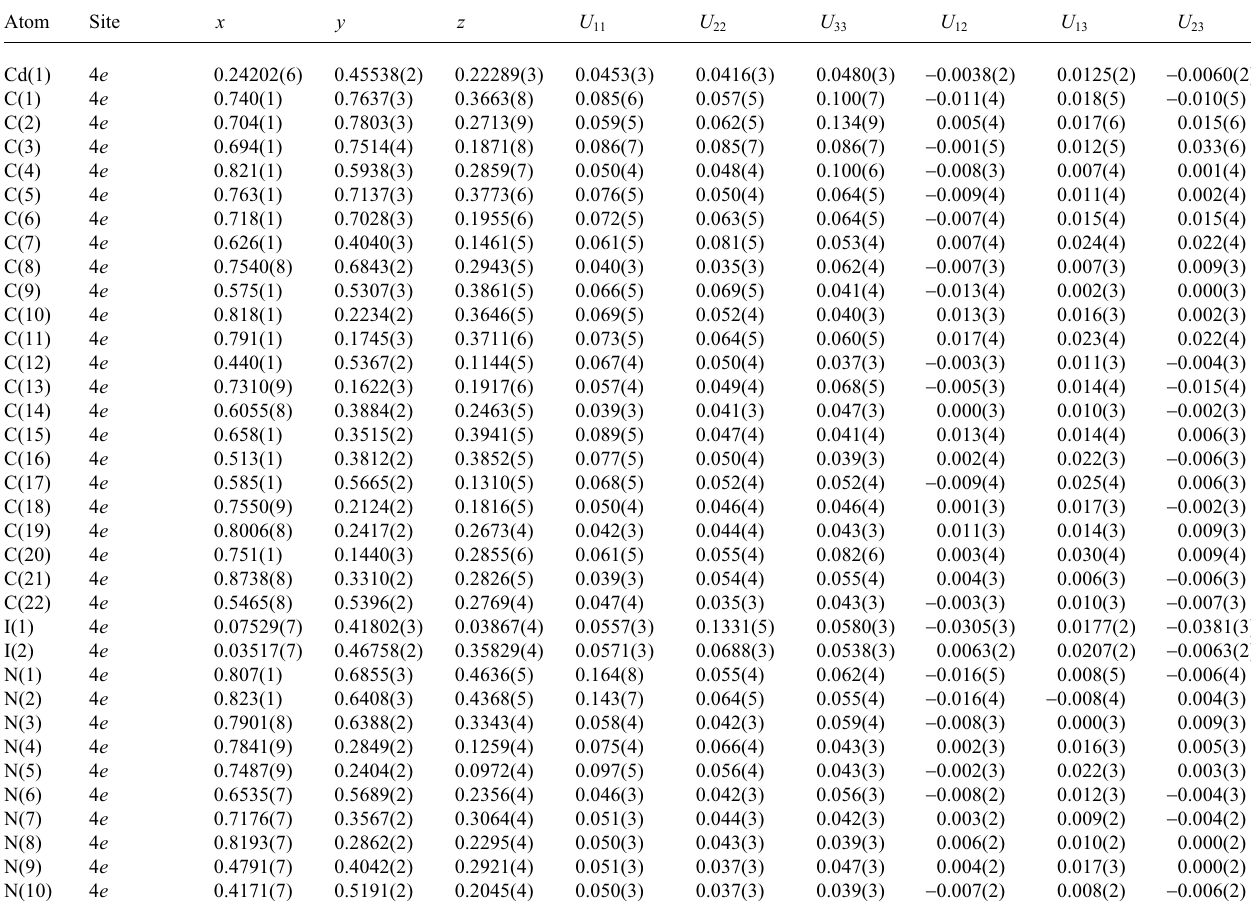
Table 3. Atomic coordinates and displacement parameters (in Å 2 )